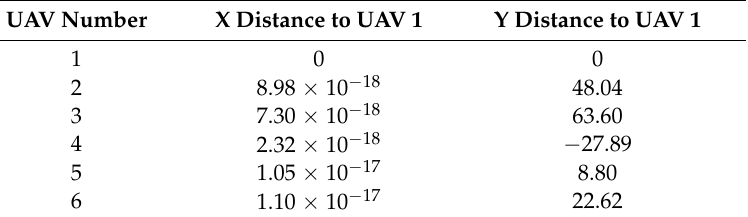
Table 1. Optimization results of indicator 1.